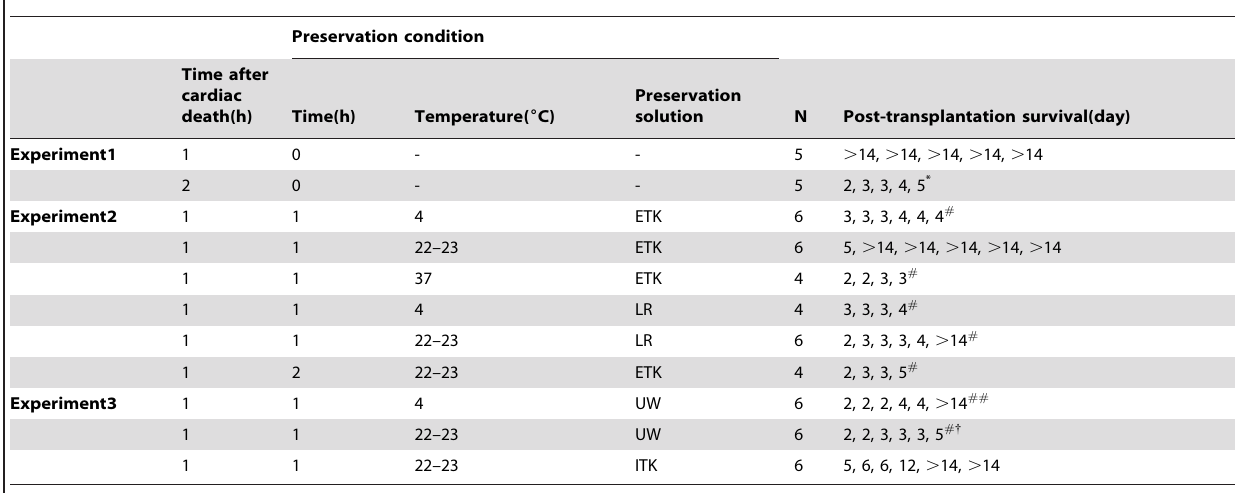
Table 1. Differentiation of survival time under each preservation